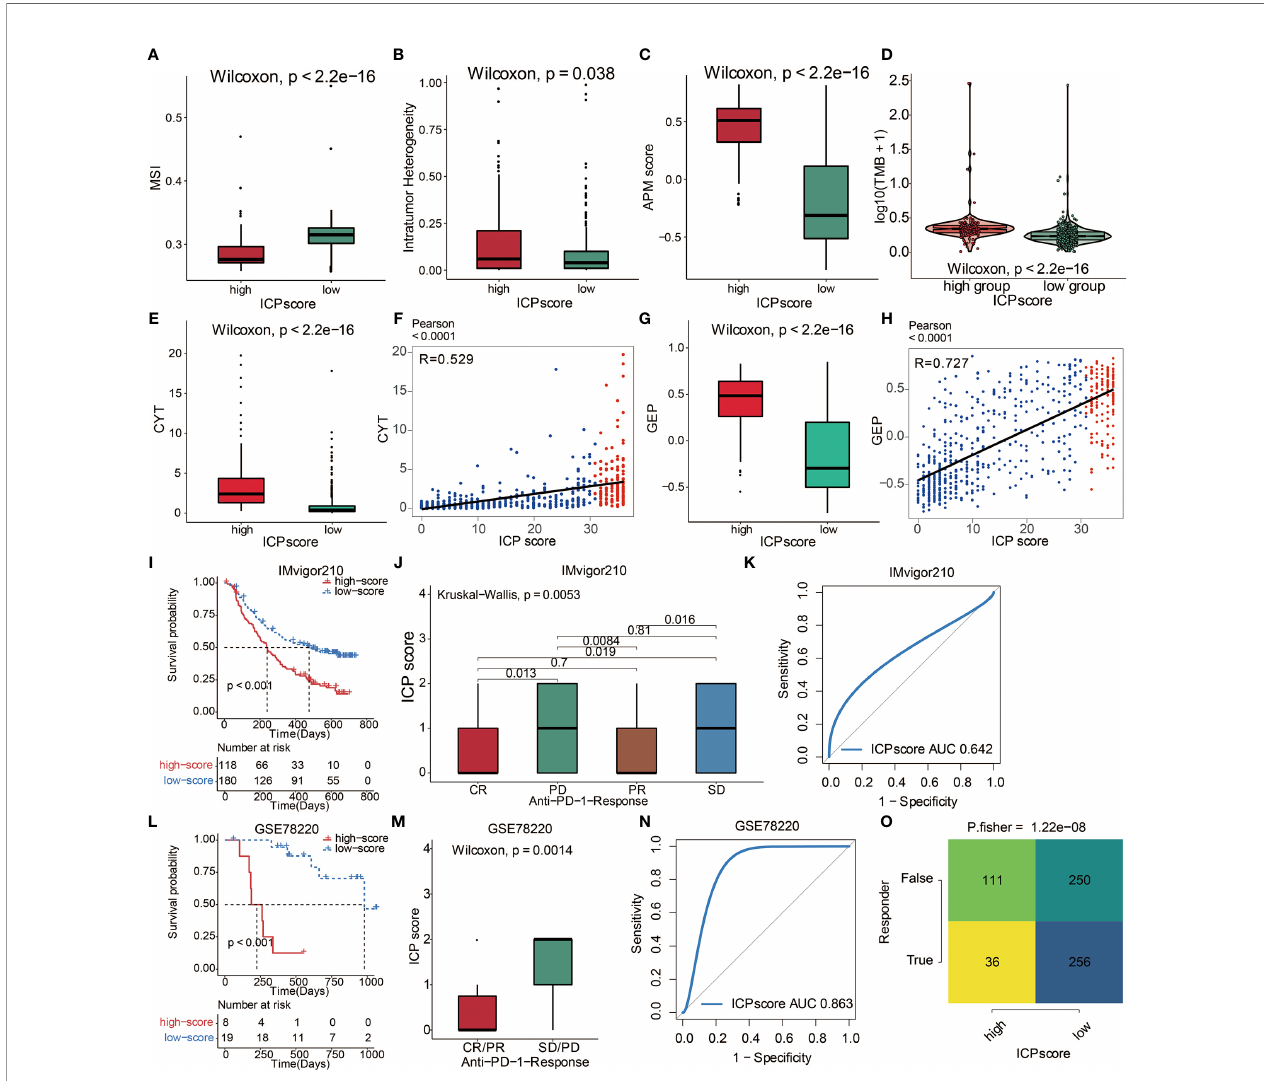
FIGURE 7 | The predictive value of ICP score in immunotherapy. (A) MSI score in high and low ICP score. (B) APM score in high and low ICP score. (C) Intratumor Heterogeneity in high and low ICP score. (D) TMB expression differences in high and low ICP score. Differences between groups were compared through the Wilcoxon test (Wilcoxon, P < 0.001). (E) CYT and (G) GEP expression differences in high and low ICP score. Differences between groups were compared through the Wilcoxon test (Wilcoxon, P < 0.001). Scatter plots depicting a positive correlation between ICP score and (F) CYT and (H) GEP. Pearson Correlation Coef fi cient R = 0.529 and 0.727, respectively. (I) Kaplan – Meier curves for the two ICP score groups in the IMvigor210 dataset. Log-rank test, P < 0.001. (J) ICP score in groups with different anti – PD-1 clinical response status (CR, PR, SD, PD). Differences between groups were compared by Kruskal-Wallis test (Kruskal-Wallis, P = 0.0053). (K) ROC curve measuring the sensitivity of ICP score in predicting the survival status of patients in the IMvigor210 dataset. The area under the ROC curve was 0.642. (L) Kaplan – Meier curves for the two ICP score groups in the GSE78220 dataset. Log-rank test, P < 0.001. (M) ICP score in groups with different anti – PD-1 clinical response status (CR/PR and SD/PD). Differences between groups were compared by Wilcoxon test (Wilcoxon, P = 0.0014). (N) ROC curve measuring the sensitivity of ICP score in predicting the survival status of patients in the GSE78220 dataset. The area under the ROC curve was 0.863. (O) TIDE value and response to immunotherapy of patients with ICP score. Fisher ’ s test, P <